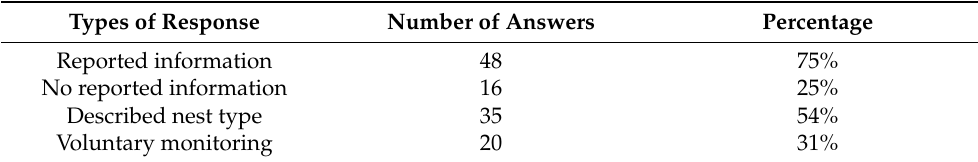
Table 2. Counts and proportions of users who did or did not submit case-specific information on free-living colonies to the COLOSS Survivors Task Force survey. In total, 64 reports on free-living colonies were submitted. The counts and proportions of instances in which the type of nests was mentioned are also given, together with those in which the user reported to be voluntarily monitoring the colonies.